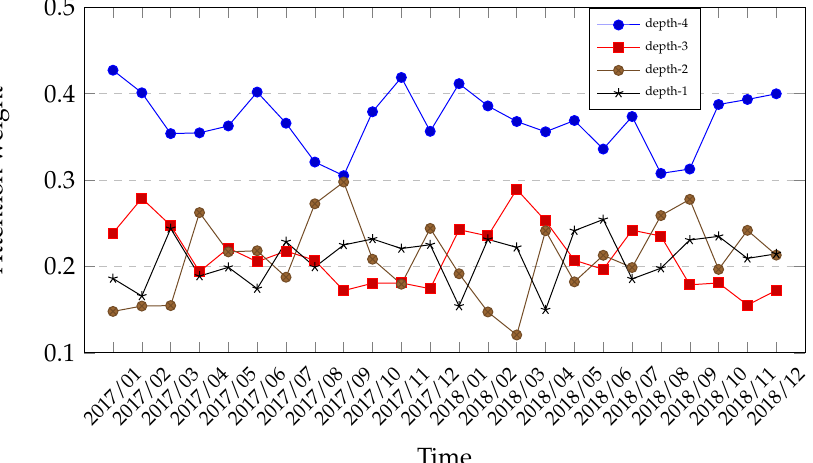
Figure 8. Attention weight on SP-CRN-2 (0,4,0) for ZH300 prediction from the average of five runs. The attention weight of depth-1 to depth-4 was the value of the prediction month for one to four prior periodic cycles. The scale is from 0.1 to